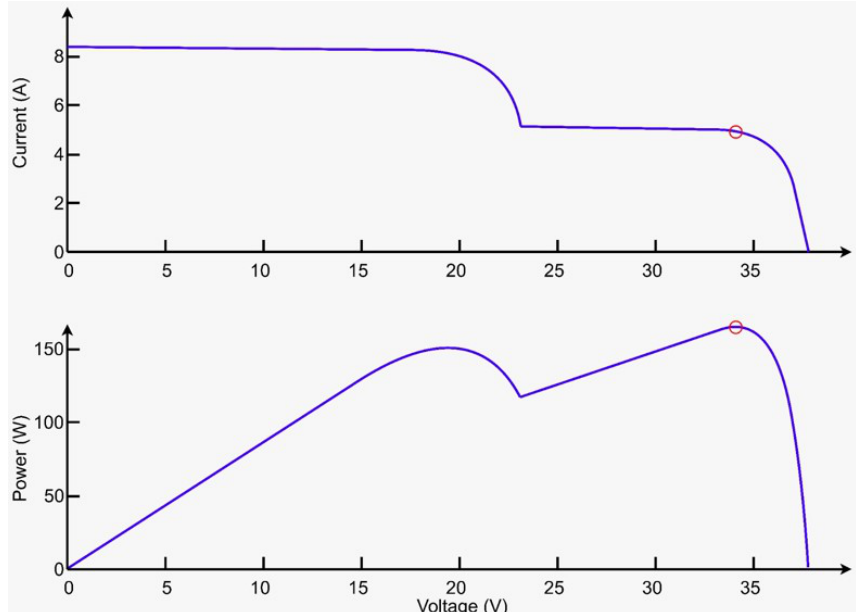
Figure 4. I–V curve example with local maximums due to the bypass diodes